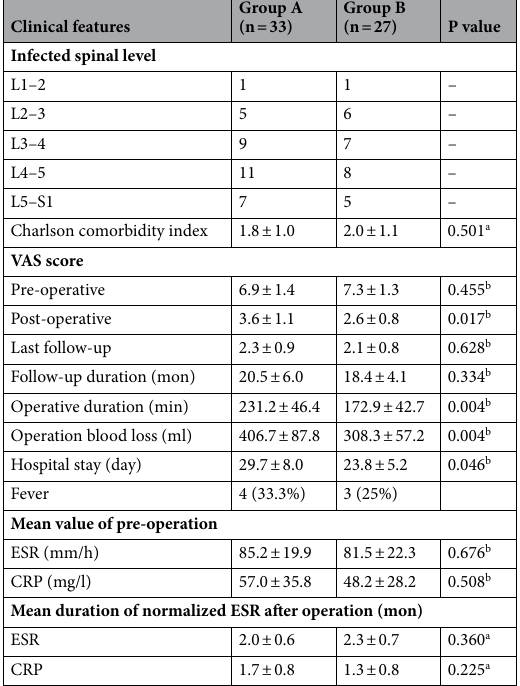
Table 1. Comparisons of clinical results between the two groups. a Data was analyzed using Mann–Whitney U test. b Data was analyzed using Student t test.